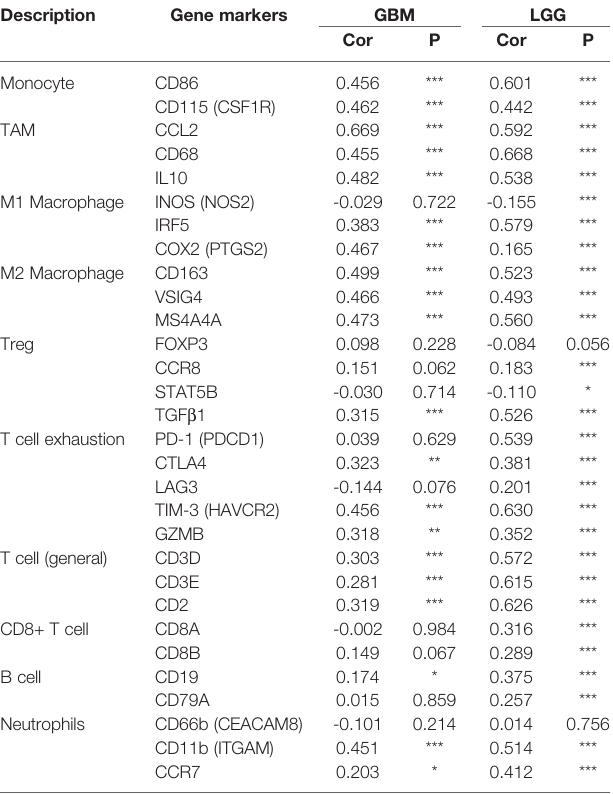
TABLE 4 | Correlation analysis between CHI3L2 and markers of immune cells in GBM and LGG.